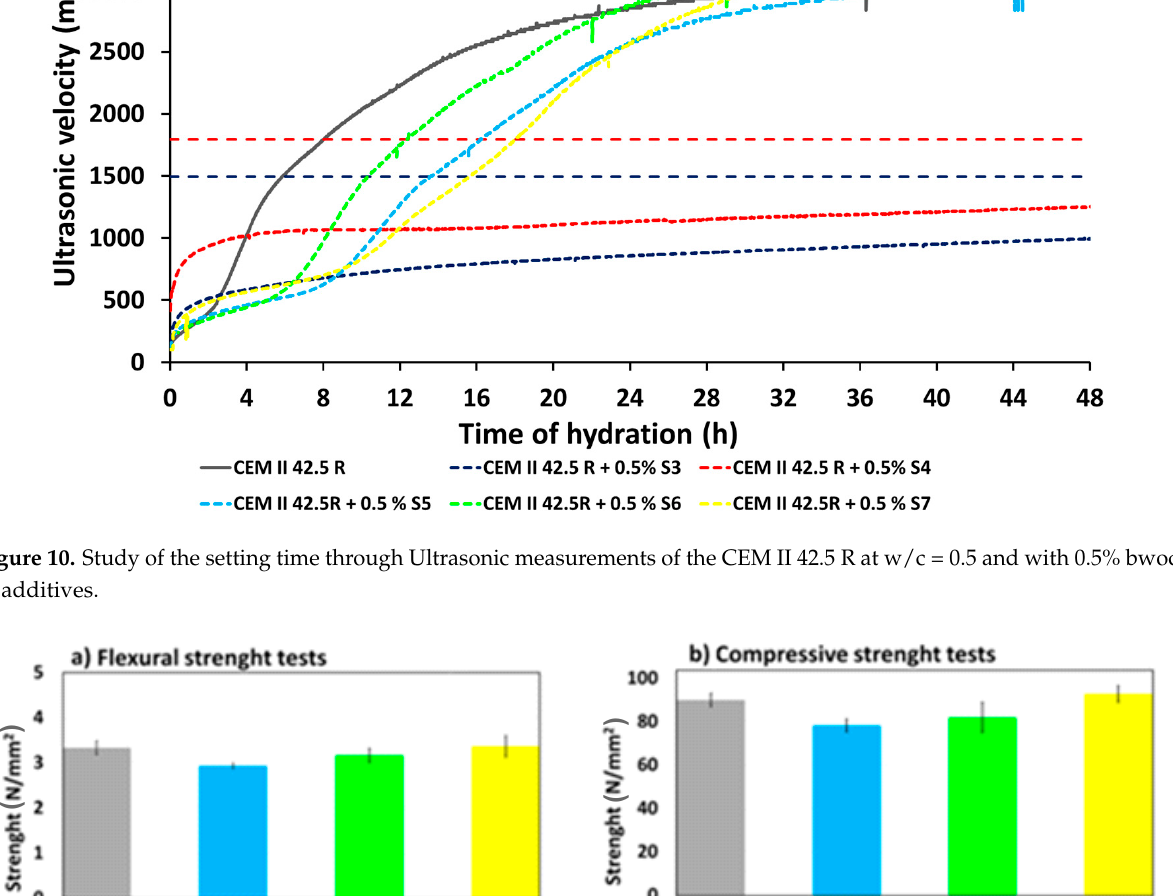
Figure 11. Mechanical properties for ( a ) flexural strength and ( b ) compressive strength of the mortar, as the only reference and the mortar doped with S5 (blue), S6 (green) and S7 (yellow) (Table 1) and at w/c = 0.35 and 1% bwoc after 28 days.